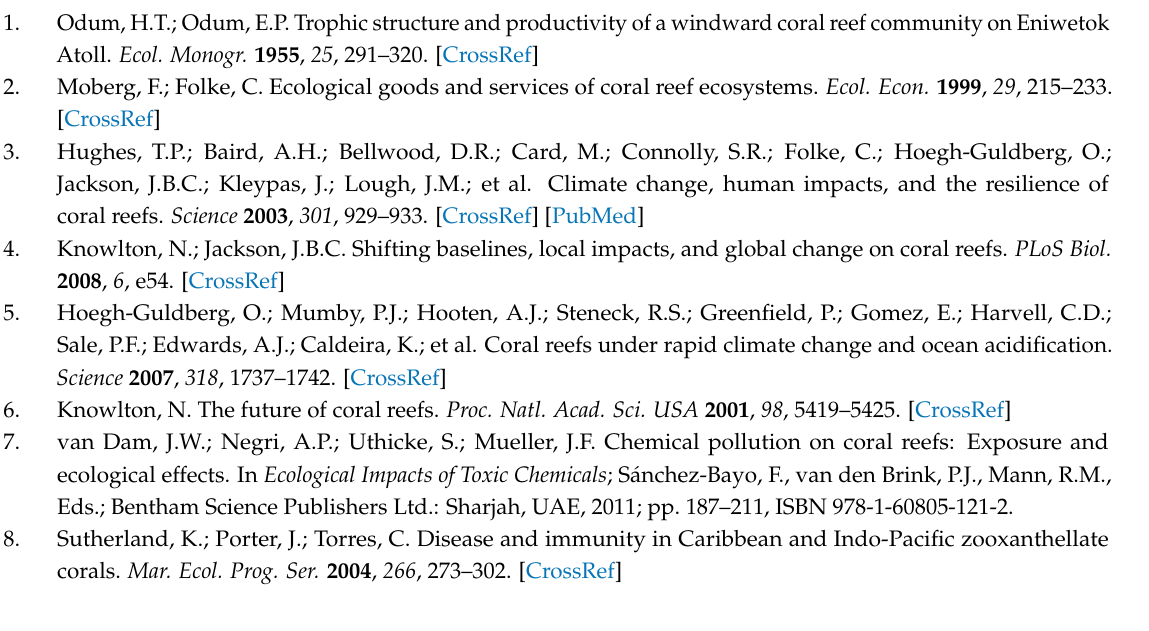
Figure S1: Representative 1 H NMR spectra and PCA score plot from the three tested extraction methods; Figure S2: Representative 1 H NMR spectra from lyophilized and frozen coral homogenates; Figure S3: Representative 1 H NMR spectra from nubbin and tissue powder subsampling methods; Figure S4: Representative 1 H NMR spectra from unaffected and growth anomaly coral samples obtained using the recommended workflow from the current study; Figure S5: Diagram of processing steps for coral nubbin and tissue powder subsampling methods; Table S1: Sample preparation methods from published coral metabolomics studies; Table S2: List of solvent volumes used for metabolite extraction from all three experiments; Table S3: List of 1 H NMR spectral exclusion regions as determined from blank samples; Table S4: Intra-colony and technical reproducibility from the current study compared to the